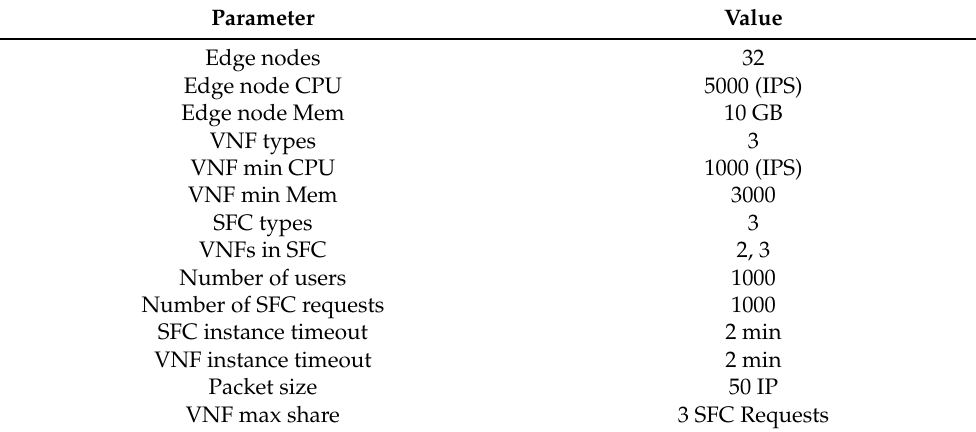
Table 5. Simulation